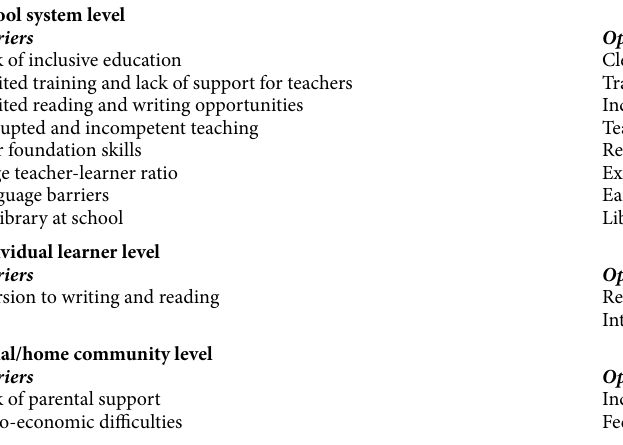
Table II. Barriers to and opportunities for written language development School system level Barriers